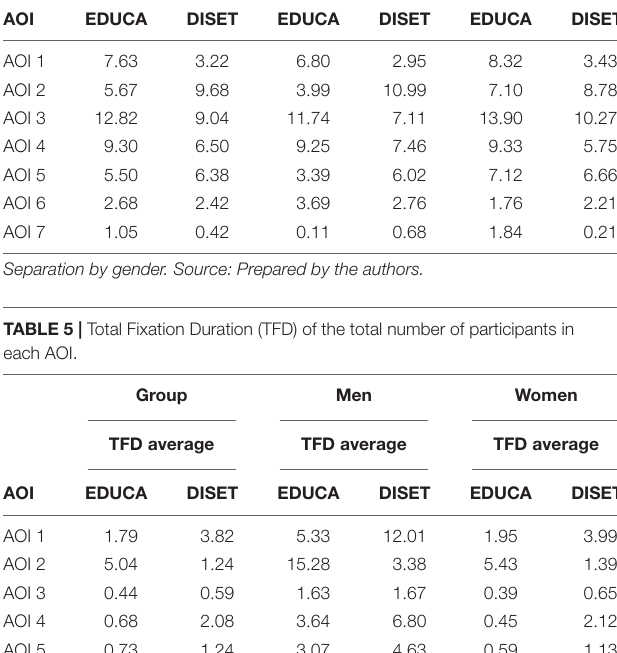
TABLE 4 | Time First Fixation (TFF) of the total of participants to each AOI. Group Men Women TFF average TFF average